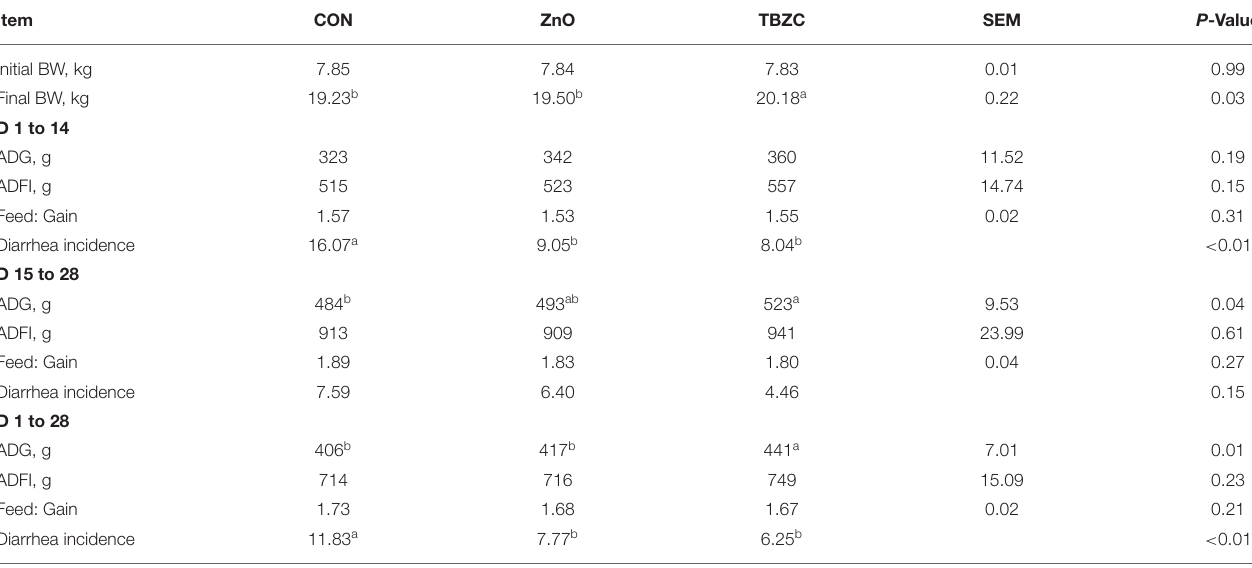
TABLE 2 | Effects of tetrabasic zinc chloride on growth performance and diarrhea incidence in weaned